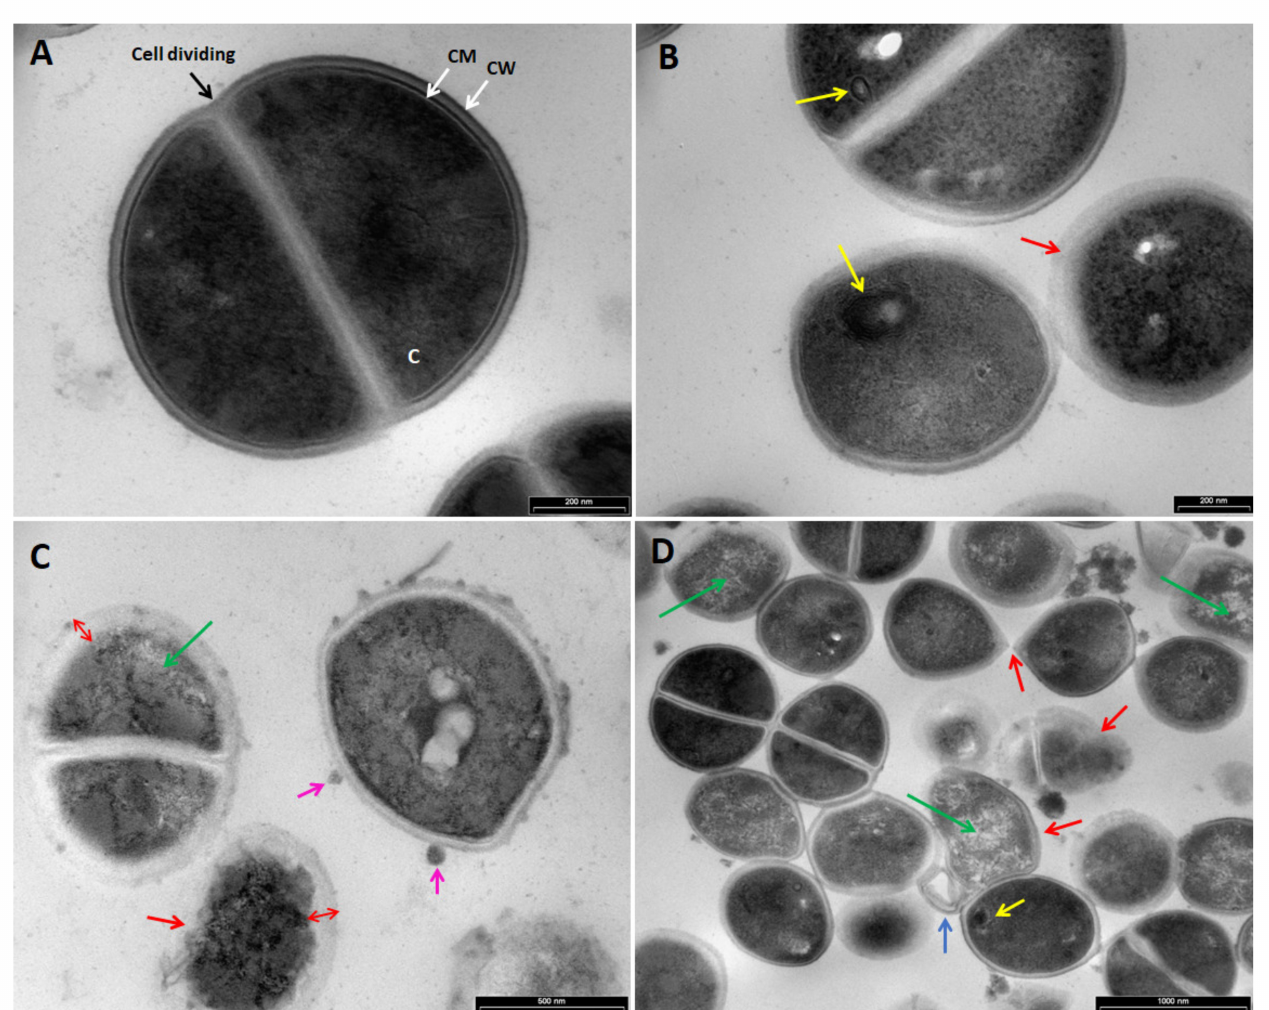
Figure 8. TEM images of Staphylococcus aureus treated with ( A ) H 2 0, no treatment control, ( B ) maltol at 4500 ppm, ( C ) DDAC at 500 ppm, ( D ) blend of maltol and DDAC (95:5) at 5000 ppm. Green arrows: loss of intracellular material. Red line and arrows: over-folding of the membrane and loss of rod shape, replaced by irregular structure. Blue arrows: intracellular material leakage observed as a membrane bound segments extending from the cell membrane. Pink arrows: bleb-like vesicles burgeoning from the bacterial surface. Yellow arrows: mesosome-like structures. Abbreviations: C: cytoplasm, CM: cell membrane, CW: cell